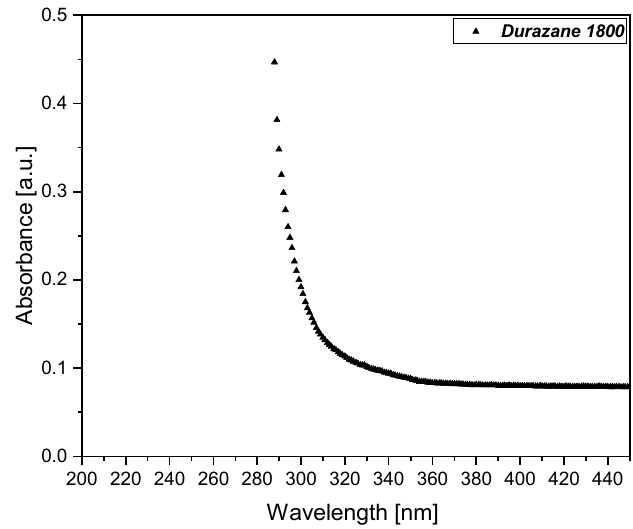
Figure A2. Thermograms of the samples cured by an LED source ( λ = 385 nm) measured in nitrogen atmosphere: ( a ) DBS 01–04, ( b ) DMABP 01–04, and ( c ) ITX 01–04. The black curves are mixtures of Durazane 1800 with 1 wt% photoinitiator concentration and the red curves are mixtures of Durazane 1800 with 3 wt% PI concentration. The dotted curves were cured in inert atmosphere and the non-dotted in ambient atmosphere. The blue curve belongs to pure uncured Durazane 1800 measured in nitrogen atmosphere .